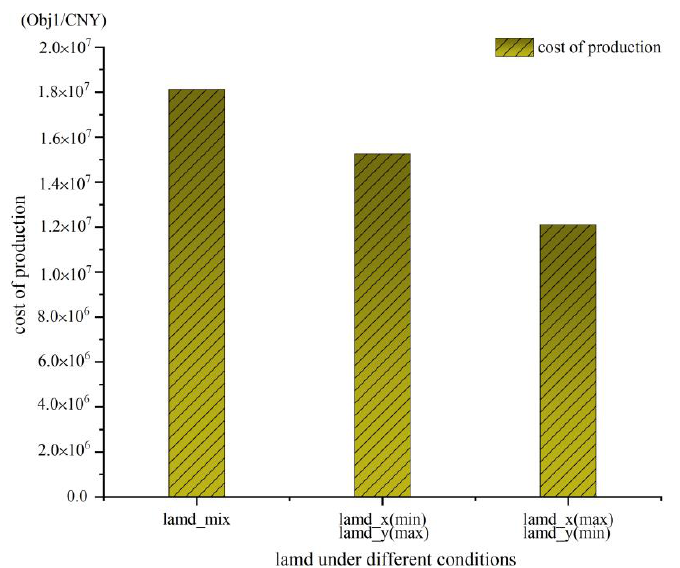
Figure 2. Production cost with attributes distinguished or not.